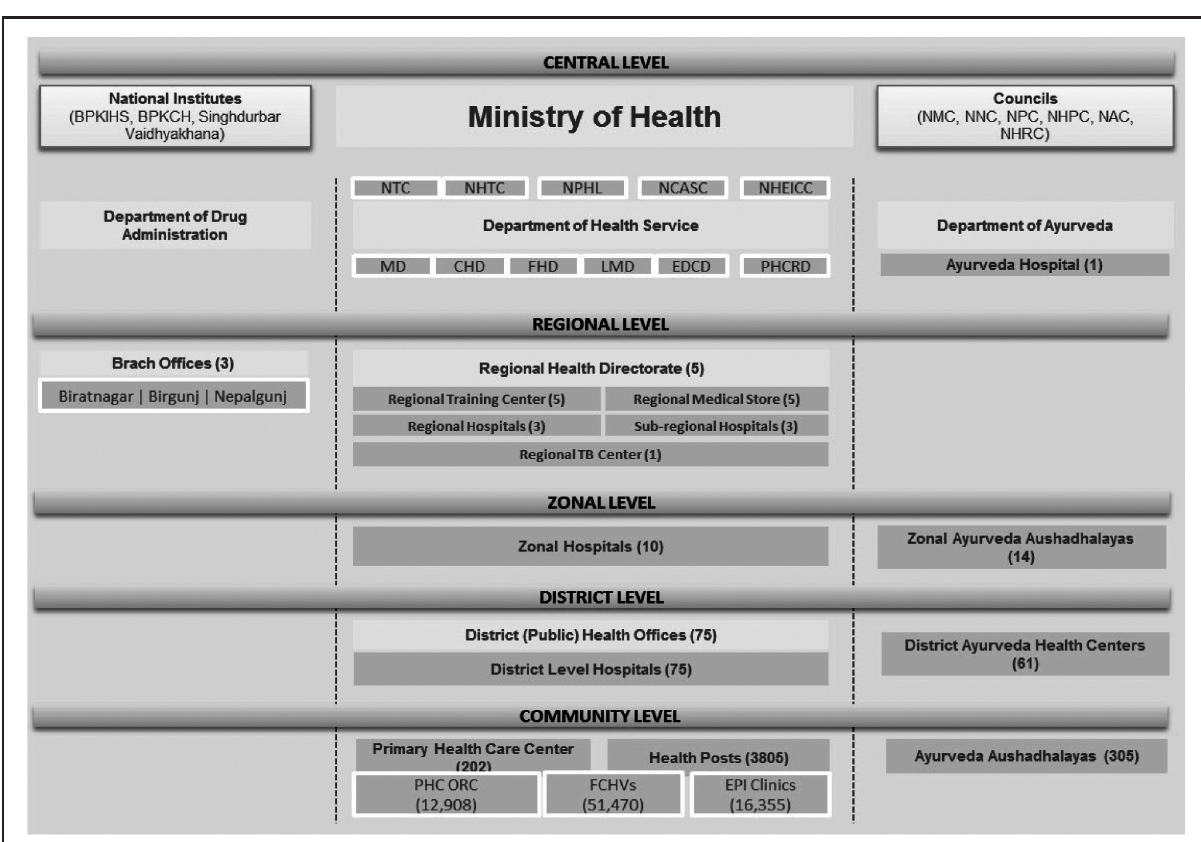
Figure 1. Organogram of the Ministry of Health (prior to